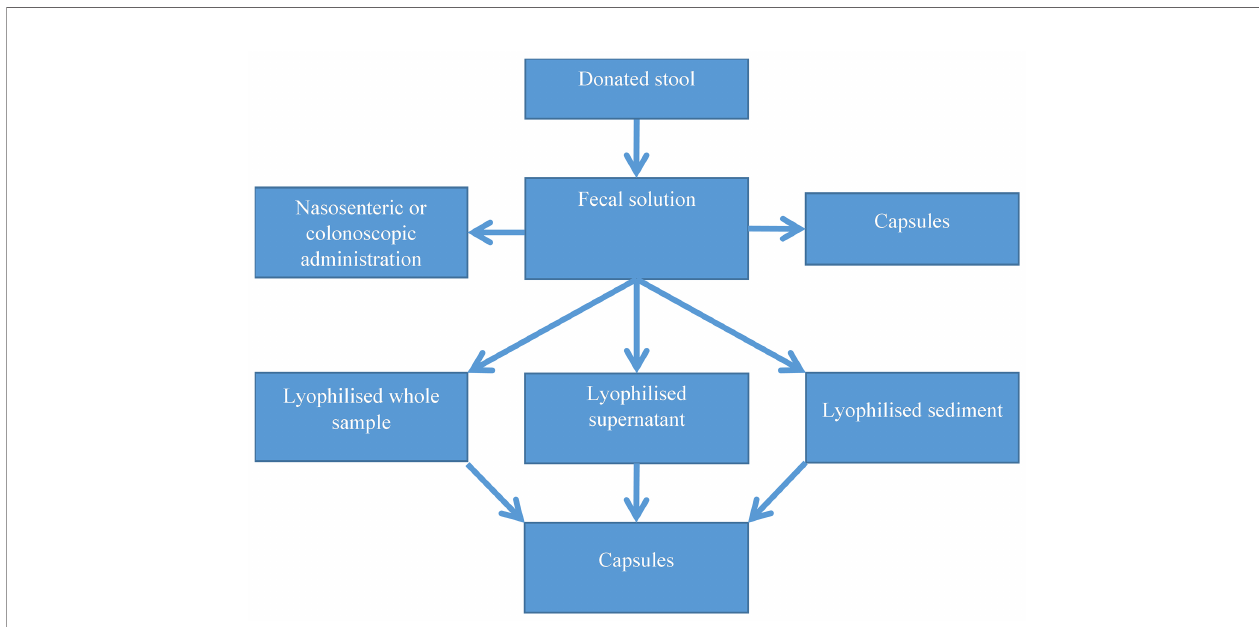
FIGURE 2 | Options to administer the faecal solution. Lyophilised samples can be resuspended and administered via a nasoenteric tube or colonoscopy (not shown in the fi